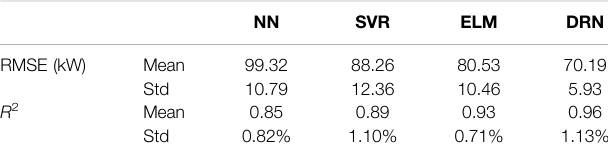
TABLE 2 | Summary of the wind power forecasting